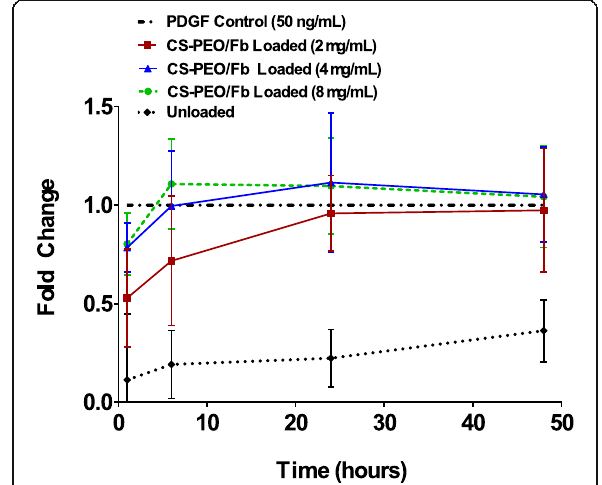
Fig. 12 Human dermal fibroblast migration after 24 h exposure to scaffold eluates acquired at 1, 6, 24, and 48 h in FBM ( n = 8, * p < 0.05 when compared to unloaded CS-PEO/Fb scaffold at each specific time